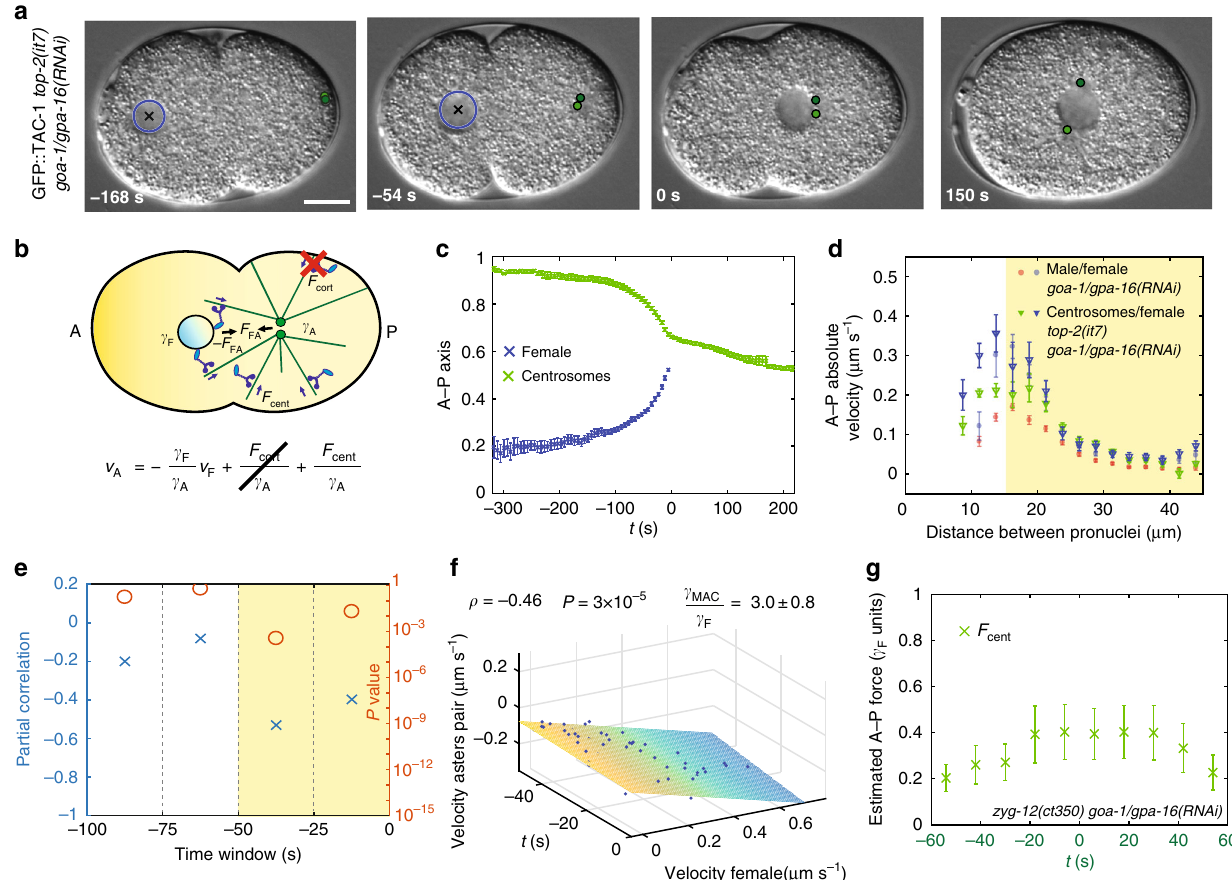
Fig. 4 Centrosome movements upon depletion of cortical dynein and without male pronucleus uncover drag coef fi cient of microtubule asters. a , b Snapshots and schematics of movements of female pronucleus and centrosomes in top-2 ( it7 ) goa-1/gpa-16 ( RNAi ) embryo. In this fi gure, time 0 s is at meeting of the asters with the female pronucleus. c Average female pronucleus and centrosome midpoint positions along the A – P axis as a function of time, with S.E.M. ( n = 10). d Absolute average velocities, with S.E.M., of the female pronucleus and the centrosome pair as a function of their distance in the indicated conditions ( goa-1/gpa-16 ( RNAi ), n = 31, same as in Fig. 3d; top-2 ( it7 ) goa-1/gpa-16 ( RNAi ), n = 10; here and in e , f , velocities are calculated between successive frames 6 s apart. The velocities of the female pronucleus during the acceleration phase in goa-1/gpa-16 ( RNAi ) and top-2 ( it7 ) goa-1/ gpa-16 ( RNAi ) are compatible ( d > 15 µ m, highlighted in yellow; χ 2 = 9; P = 0.76), whereas the velocities of the male-asters complex and of the asters pair are not ( χ 2 = 105; P < 1 × 10 − 16 ). e Partial Pearson ’ s correlation, controlling for time variation, between the velocities of the female pronucleus and the two asters along the A – P axis over successive time windows ( n = 10, partial correlation: blue crosses; P value (Student's t test, two-sided): orange circles; the correlated time window is highlighted in yellow). f Velocity of male pronucleus as a function of time and of female pronucleus velocity during the correlated phase of pronuclear migration in top-2(it7) goa-1/gpa-16 ( RNAi ) embryos ( n = 10, − 50 < t < 0 s time window). Plane: linear fi t v A ¼ (cid:2) γ F γ v F þ v 0 þ mt v 0 ¼ (cid:2) 0 : 11 ± 0 : 04 ð Þ μ ms (cid:2) 2 ; errorsareS : D : ð Þ . g Centering force (with S.E.M., n = 8 ) acting on MAC the asters pair in zyg-12 ( ct350 ) goa-1/gpa-16 ( RNAi ) embryos as a function of time. Since pronuclear meeting does not occur in zyg-12(ct350) goa-1/gpa-16 (RNAi) embryos, time 0 s is de fi ned as the half-centration time (indicated by the green lettering on the x axis; microtubule asters, centrosomes move faster toward the cell center in top-2(it7) goa-1/gpa-16(RNAi) embryos than in zyg-12 (ct350) goa-1/gpa-16(RNAi) embryos, in which that pull is absent (Supplementary Fig. 5b, c).